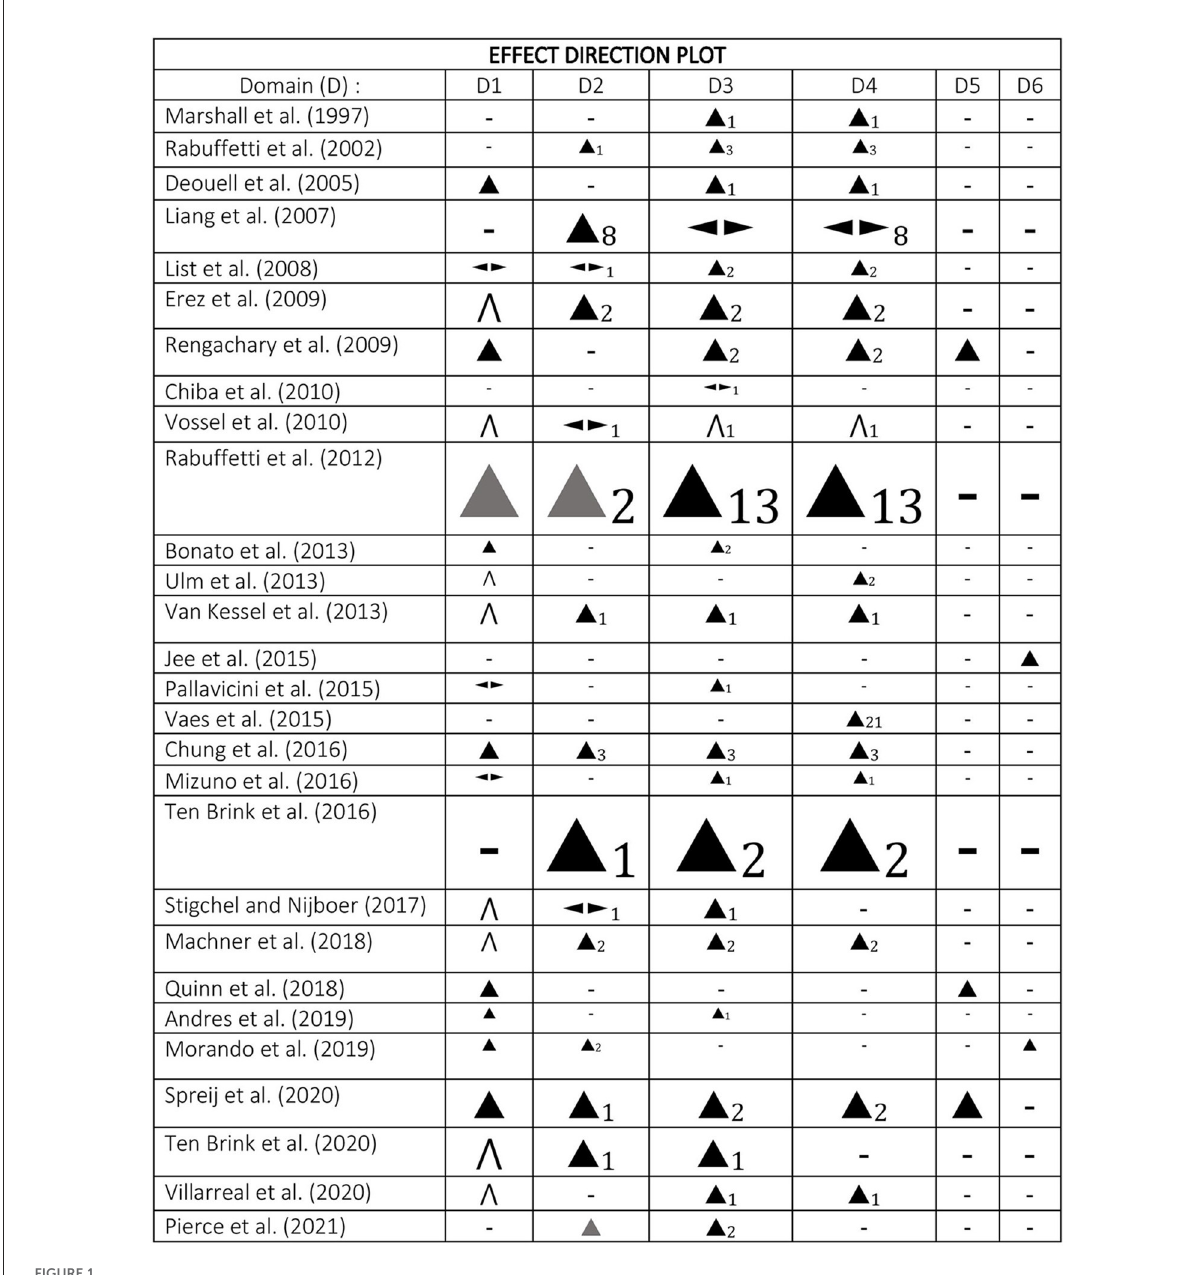
FIGURE1 Effect direction